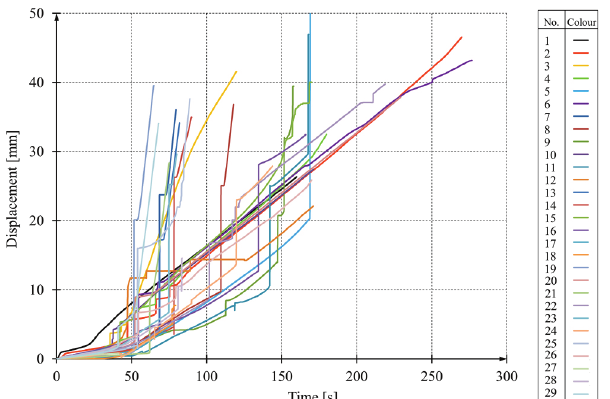
Fig. 21a. Pile slip on load application plane in concrete specimens over time